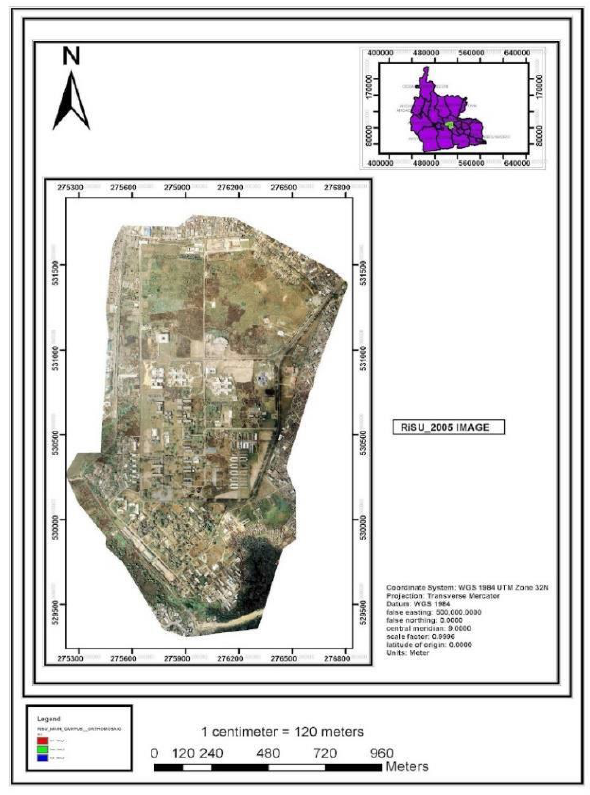
Figure 3: 2005 Orthophoto Imagery of Rivers State University Portharcourt